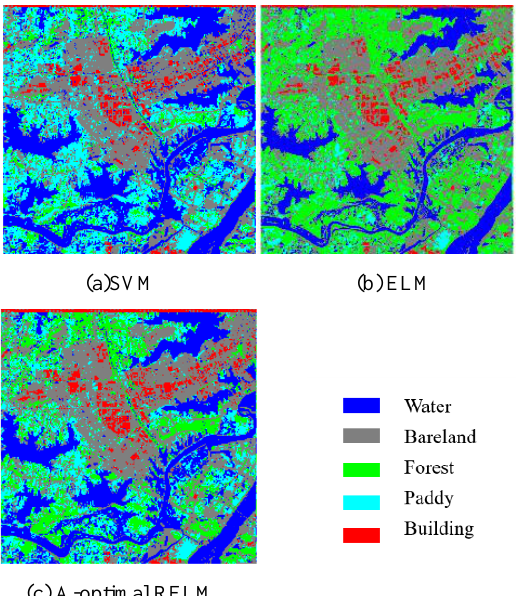
Figure 3. classification results based on Wuhan East Lake